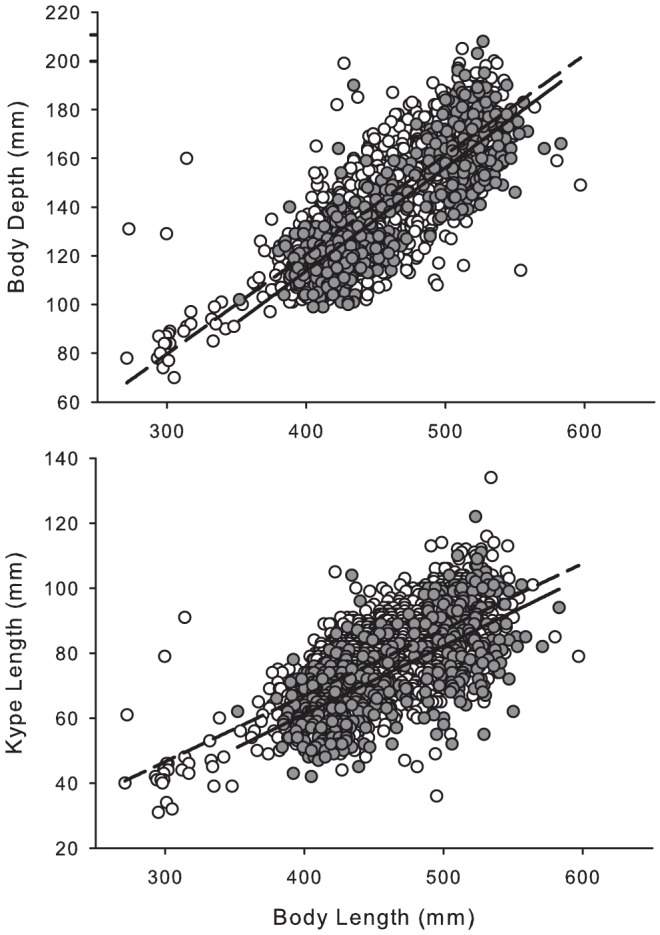
Linear regression of body depth (top panel) and kype length (bottom panel) as a function of body length in males sampled at spawning streams.Uninjured fish (○,– –, Mean Length 452±0.97 mm SE, n = 1864) exhibited increased traits associated with reproduction maturity relative to injured fish (•, _ , Mean Length 462±2.18 mm SE, n = 501).